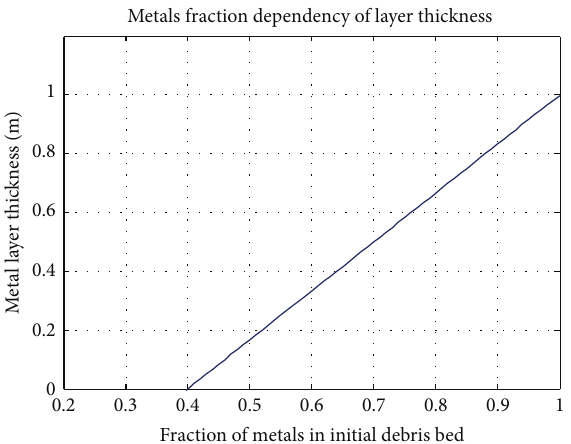
Figure 17: Dependency of metal layer thickness on fraction of metallic components in the initial debris bed ( ∼ 180